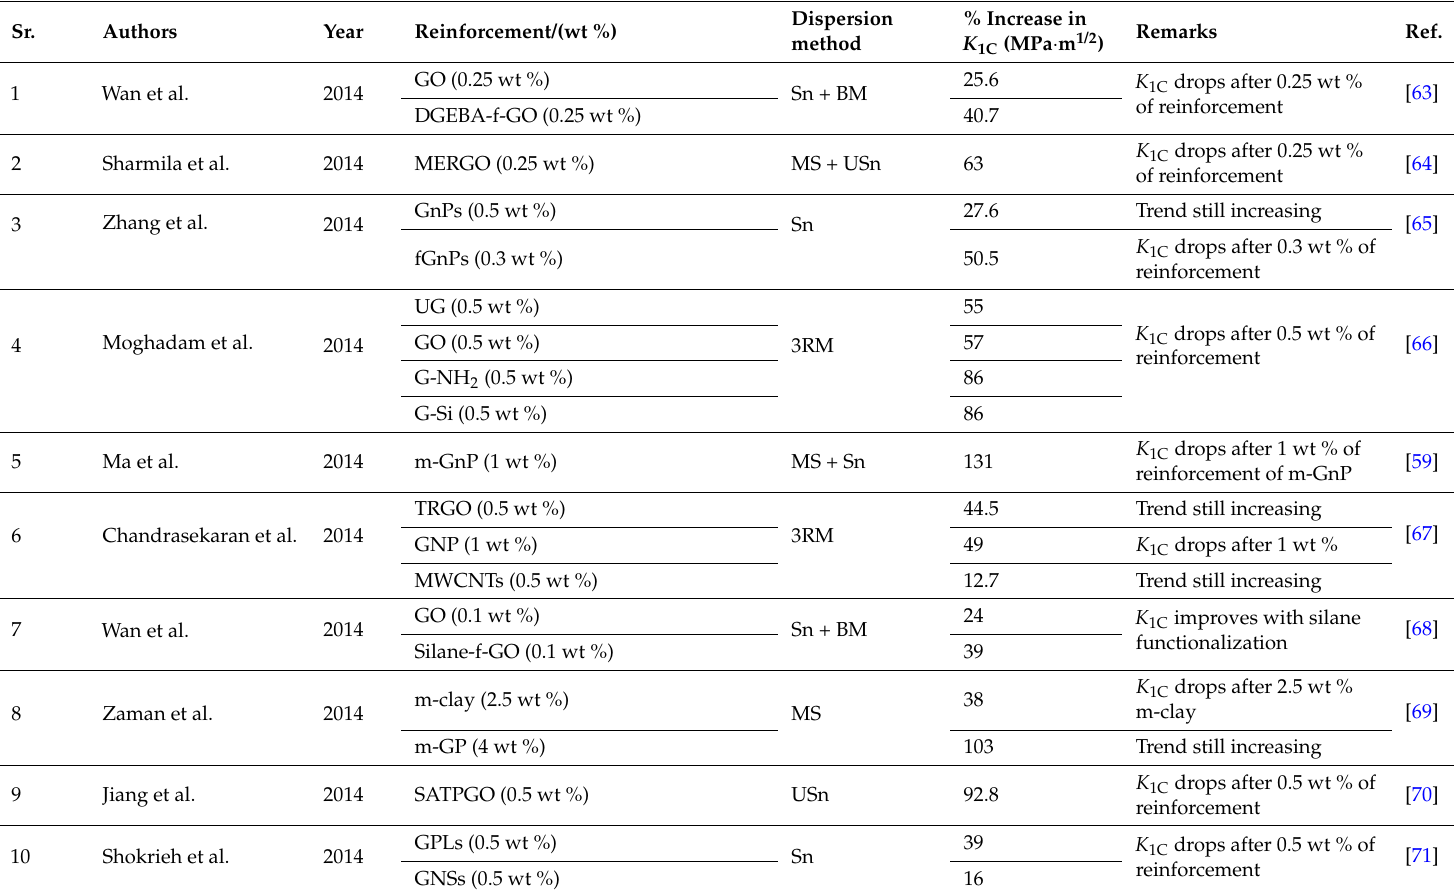
Table 1. A brief record of epoxy-based nanocomposites studied for improvement in fracture toughness